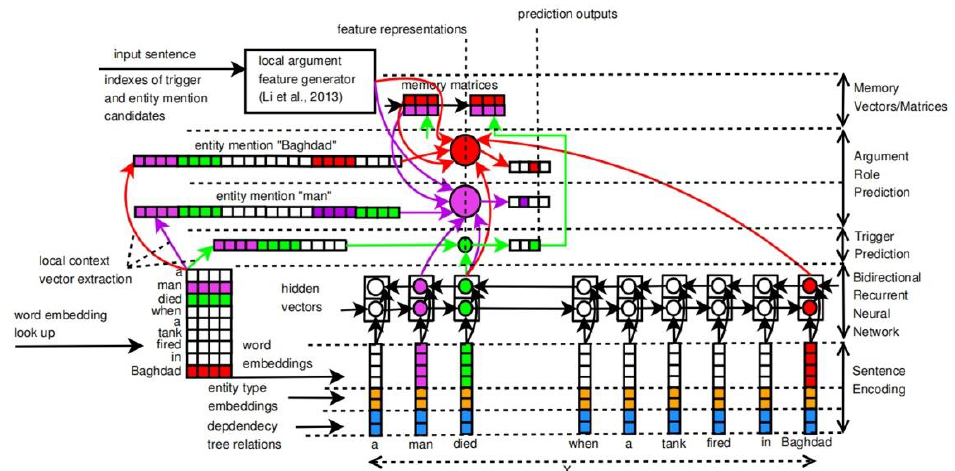
Figure 6. The architecture of JRNN, which reduces the propagation of error by combining local and global features in the recurrent neural network and designing different memory matrices to enhance the connection of different events [73].